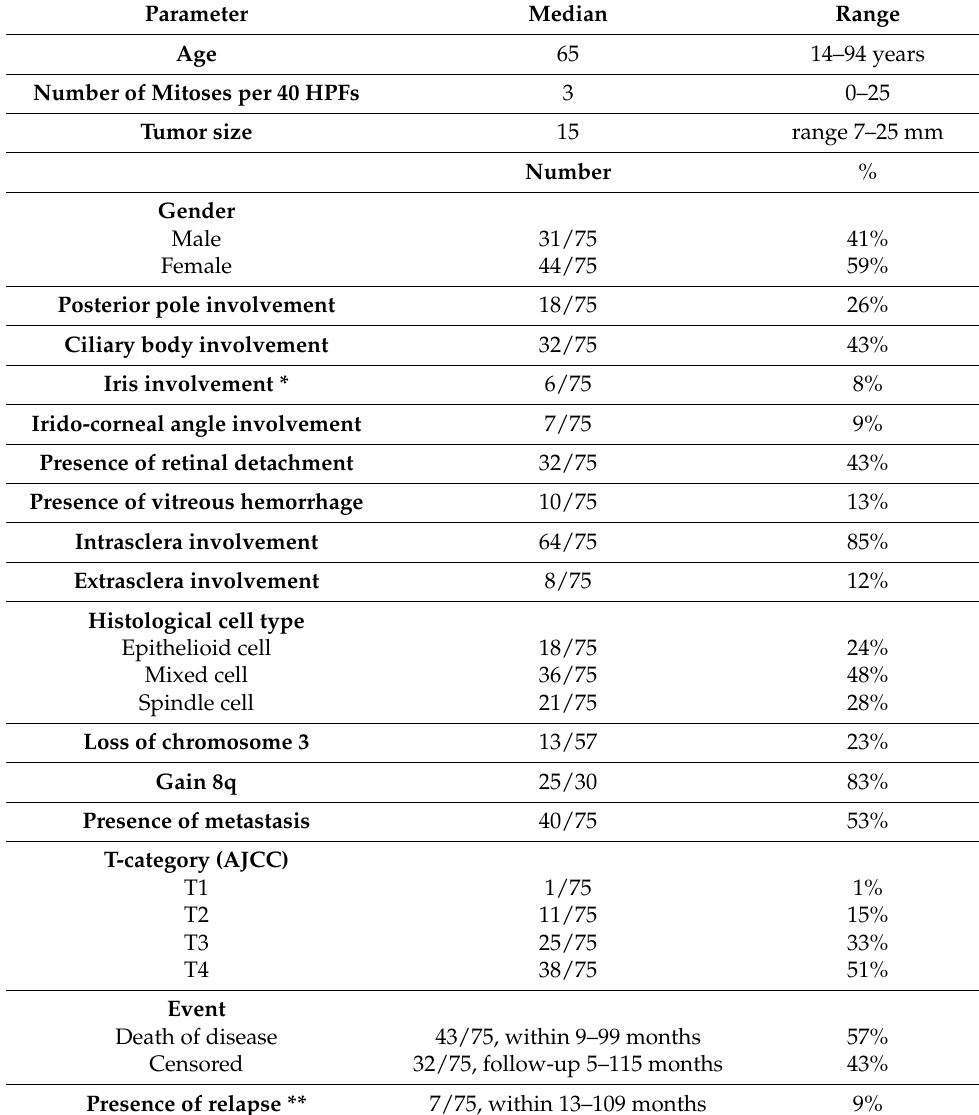
Table 1. Clinicopathological characteristics of 75 patients with UM (* per continuitatem, ** presence of disease after a disease-free period of time following initial